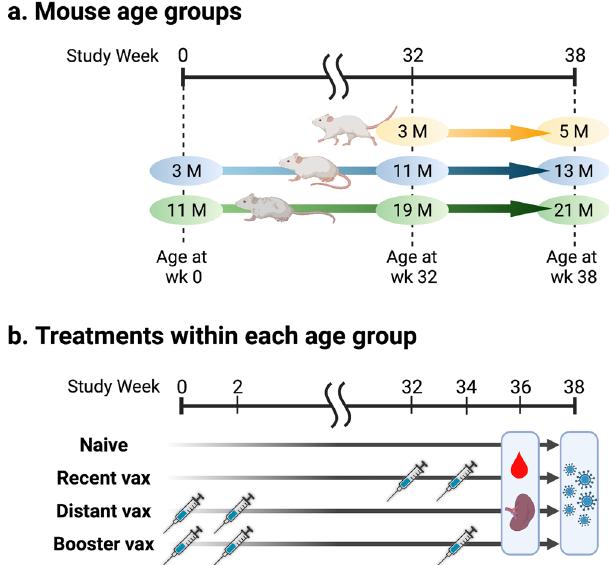
Fig. 1 Study design outlining longitudinal immunization of mRNA BNT162b2 across the lifespan. Schematic representation of the study design showing three mouse age groups ( a ) and treatments within each age group ( b ). Three- and 11-month-old BALB/c mice were included in the study at week 0 and received the following treatments: mock PBS injection (naive); primary mRNA vaccination series at weeks 32 – 34 (recent vax); primary vaccination series at weeks 0 – 2 (distant vax); and primary vaccination series at weeks 0 – 2 with booster dose at week 34 (booster vax). Additionally, 3-month-old BALB/c mice were enrolled in the study at week 32 and received the following treatments: mock PBS injection (naive); and primary vaccination series at weeks 32 – 34 (recent vax). N = 20 per group at enrollment. Serum samples were collected at week